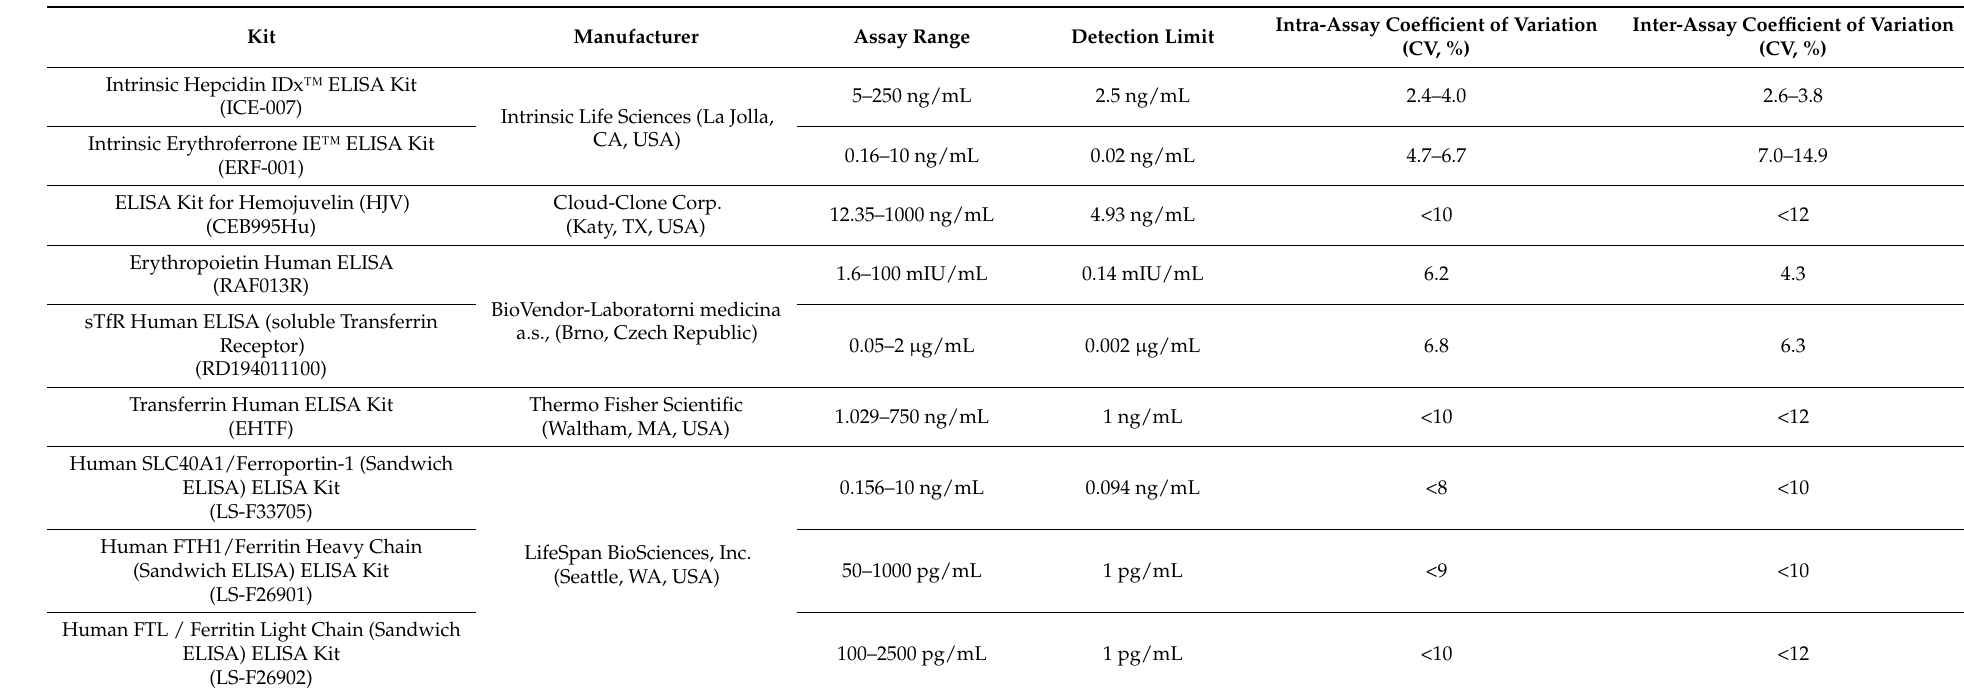
Table 2. The main features of enzyme-linked immunosorbent assay (ELISA) kits used in the current